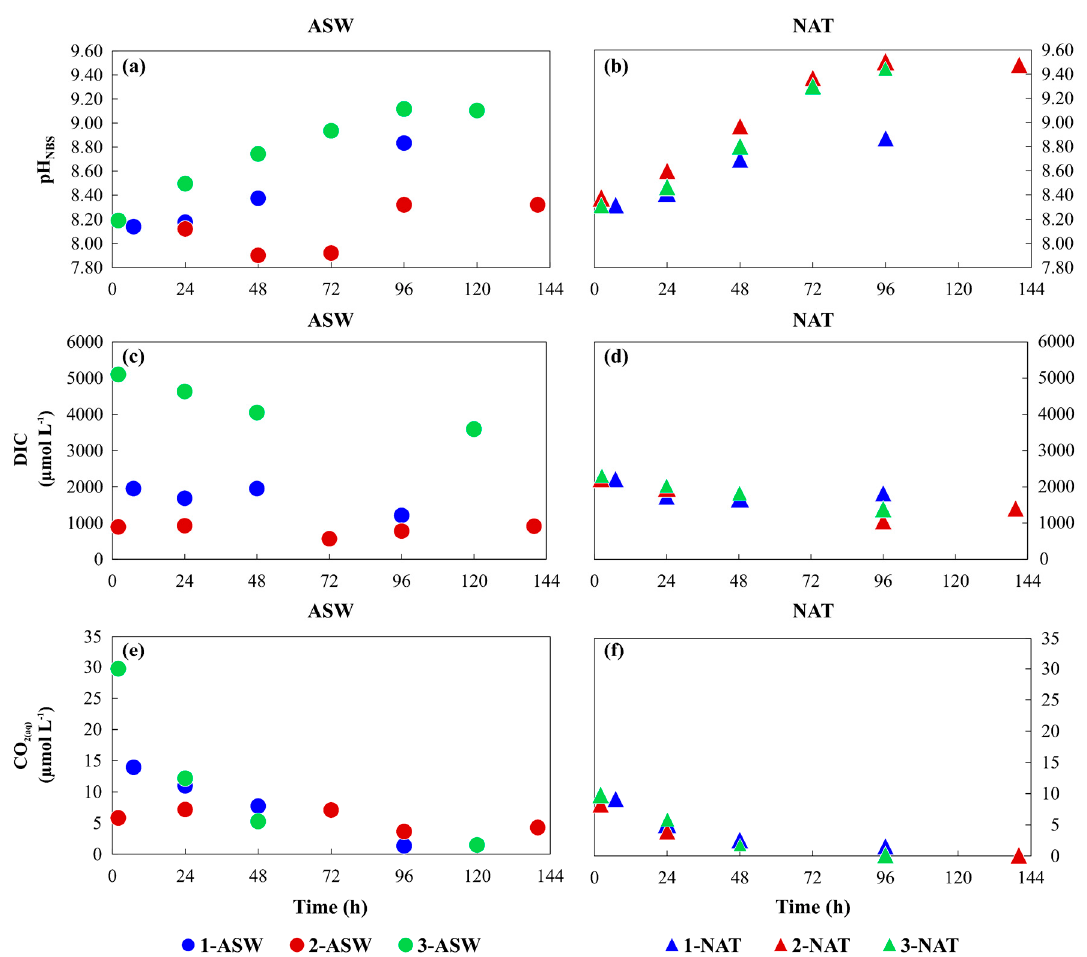
Figure 3. Time variation of the ( a , b ) pH NBS , ( c , d ) dissolved inorganic carbon (DIC) and ( e , f ) dissolved CO 2(aq) during the three T. rotula culture experiments. Circles represent the artificial seawater medium (ASW) and triangles the natural seawater medium (NAT). Blue symbols represent the first experiment (EXP-1), red the second experiment (EXP-2) and green the third experiment (EXP-3).